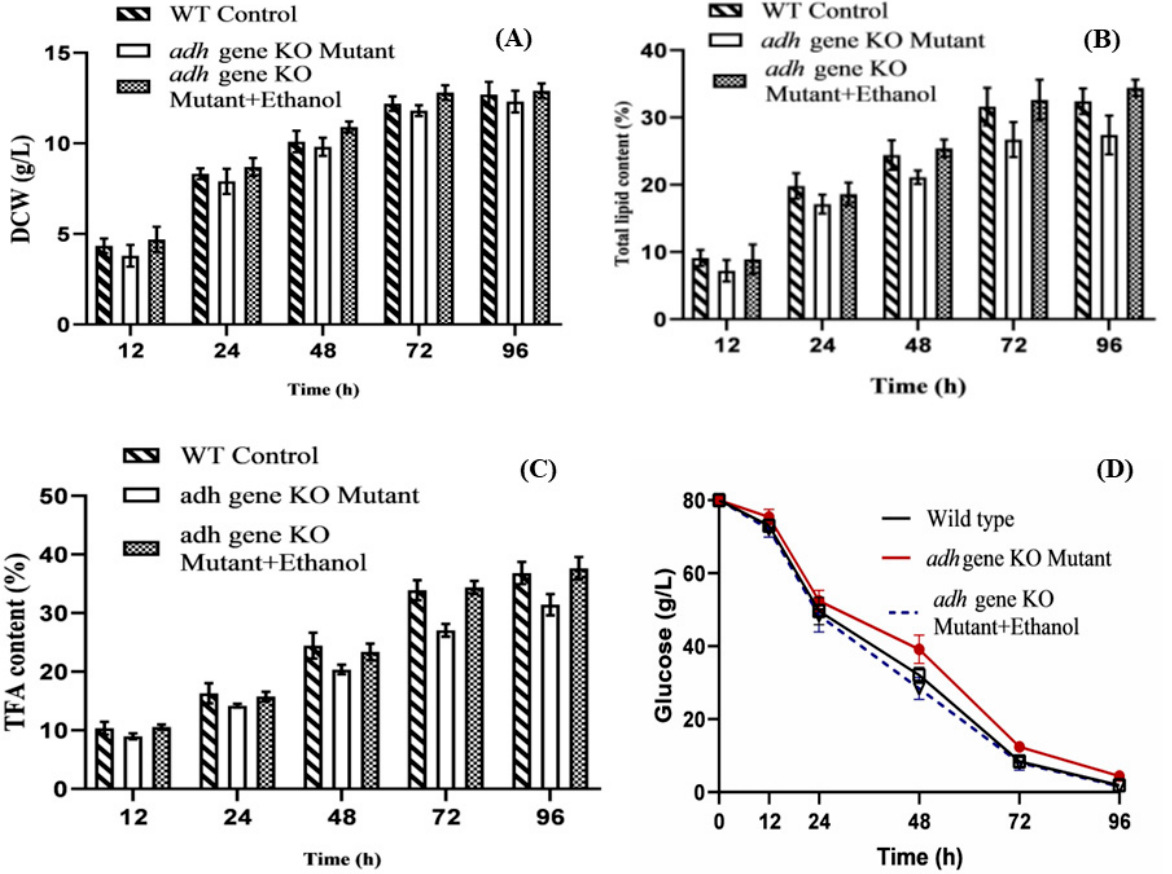
Figure 2. Comparison of dry cell biomass ( A ), total lipid production ( B ), total fatty acid content ( C ), and glucose utilization ( D ) of wild type, adh 1 knockout mutant only, and adh 1 knockout supplemented with 0.5% ethanol in batch cultures. Values were the mean of three independent fermentation experiments. Error bars represent the standard error of the mean.